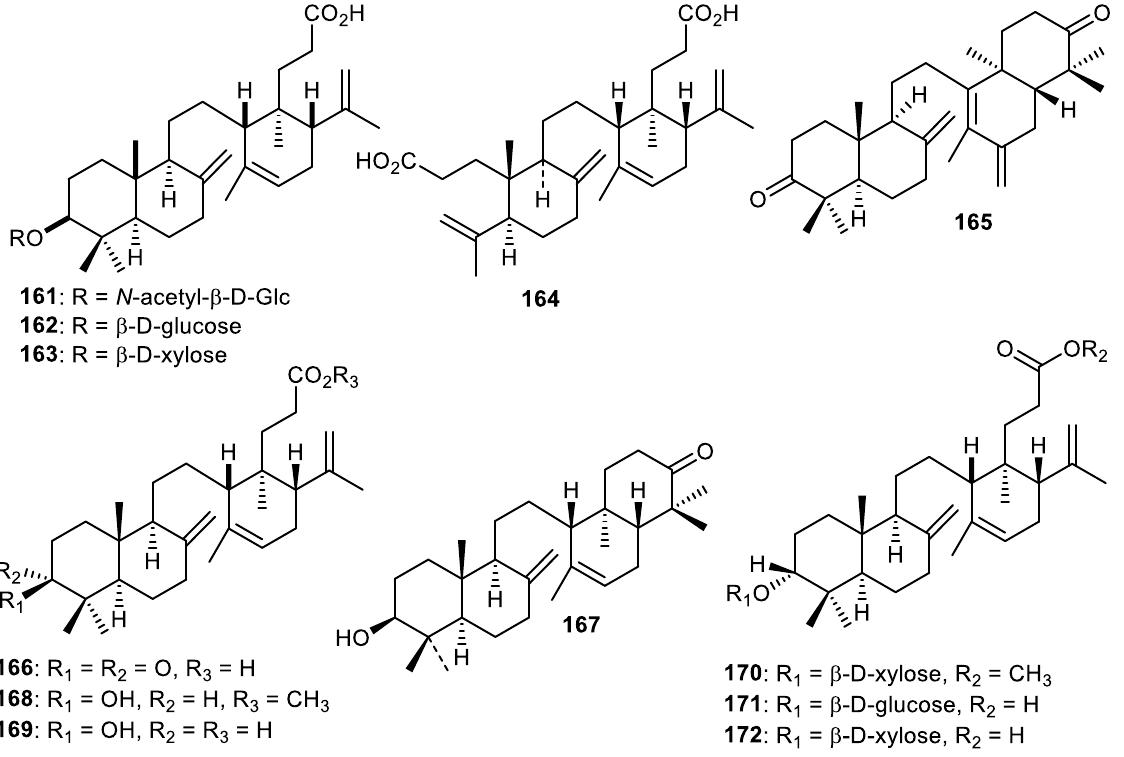
Figure 20. Structures of onocerane triterpenoids 161 – 172 .